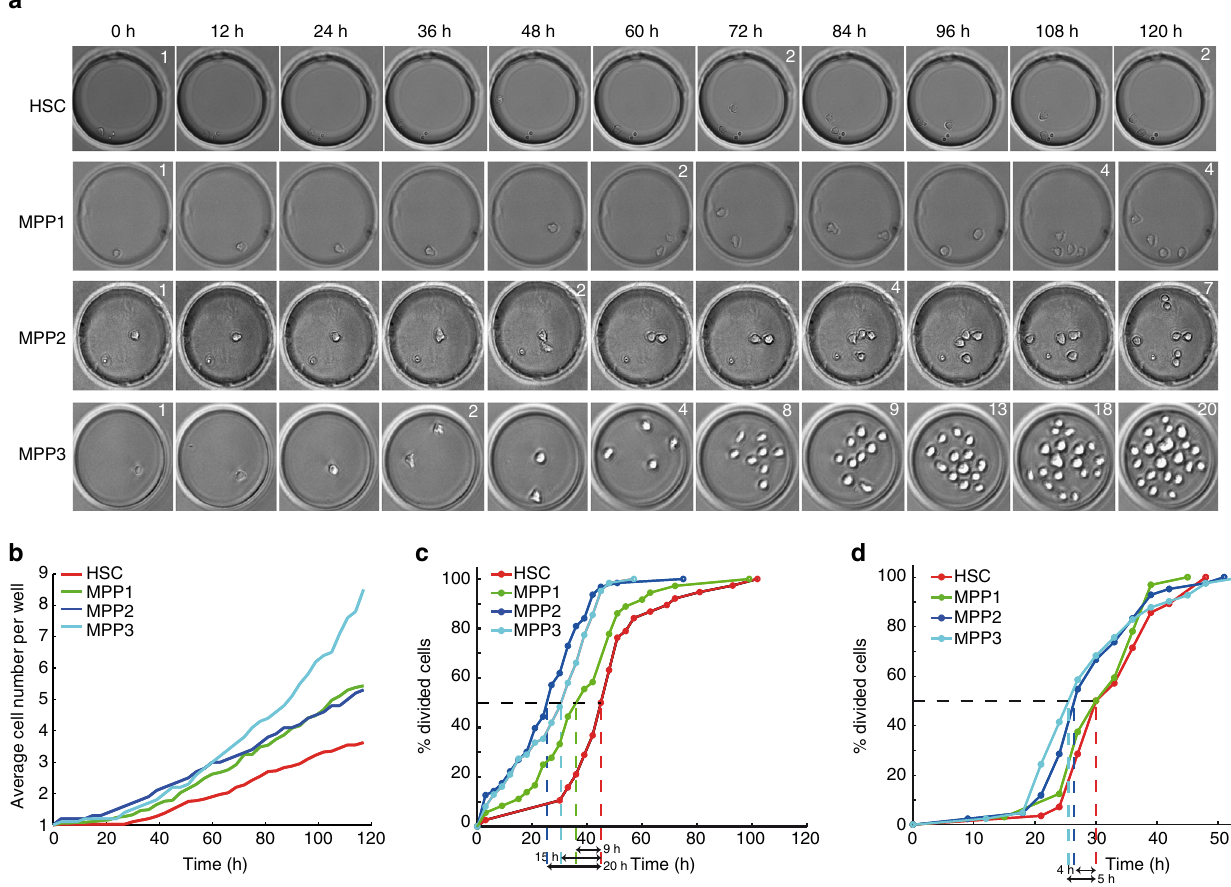
Fig. 2 HSCs have a slower division kinetics compared to MPPs. a Representative images from time-lapse microscopy showing proliferation of single HSC, MPP1, MPP2 or MPP3 in 100 µ m-wide microwells. White numbers indicate number of cells in the microwell. b Average proliferation of indicated populations ( red , HSC; green , MPP1; blue , MPP2; turquoise , MPP3) for single cells of each population cultured for 120 h in microwells. Dead cells excluded (Percentage dead cells, HSC 48.7%, MPP1 27.4%, MPP2, 28.5%, MPP3 48.5%). c Cumulative histogram of time until fi rst division for indicated populations ( red , HSC; green , MPP1; blue , MPP2; turquoise , MPP3). d Cumulative histogram of time between fi rst and second division for indicated populations ( red , HSC; green , MPP1; blue , MPP2; turquoise , MPP3). Number of live single cells for HSC n = 40, MPP1 n = 37, MPP2 n = 60, MPP3 n = 53. See also Supplementary Fig. 2 and Supplementary Movies 1 –